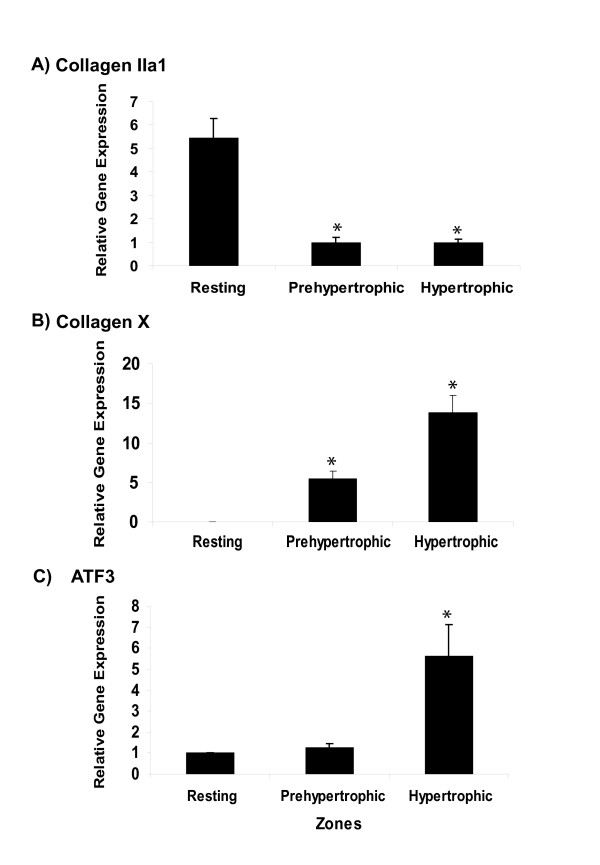
Atf3 expression is upregulated during chondrocyte differentiation in vivo. Tibia isolated from embryonic day 15.5. mice were microdissected into the resting/proliferating, prehypertrophic and hypertrophic areas, and RNA was isolated directly out of cartilage. Expression of type II collagen II (Col2a1), type X collagen (Col10a1) and Atf3 was examined by real-time PCR analyses and normalized to Gapdh expression. All data represent averages and SEM from four independent experiments (*: p < 0.05). Col2a1 was strongly expressed in the resting/proliferating area and declined subsequently (A). Col10a1 was virtually undetectable in the resting/proliferating area and strongly induced in the prehypertrophic and hypertrophic areas (B). Atf3 was already expressed in the resting/proliferating area, but expression was significantly increased in the more mature zones of the growth plate.